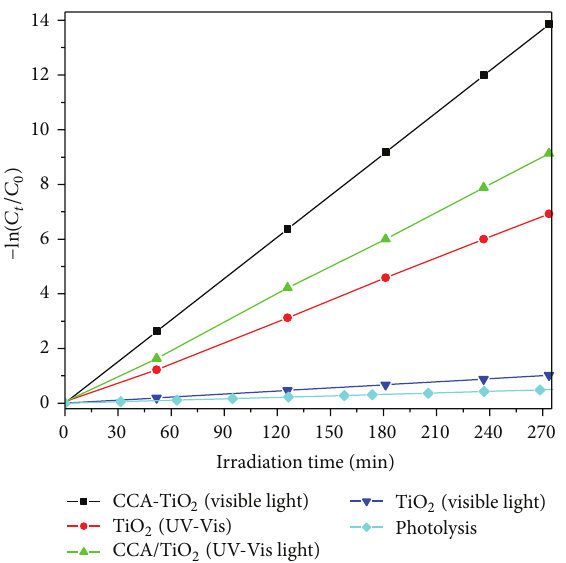
Figure 2: Linear transform graph of degradation of Rhodamine B by free titania CCA/TiO 2 under UV and visible-light illumination.